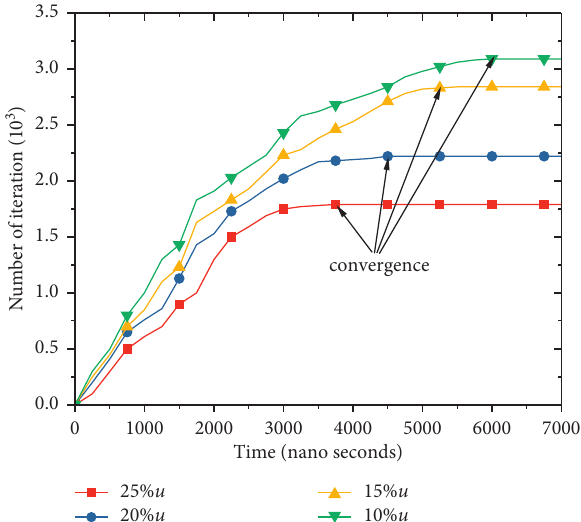
Figure 8: The total migration cost versus time and r .